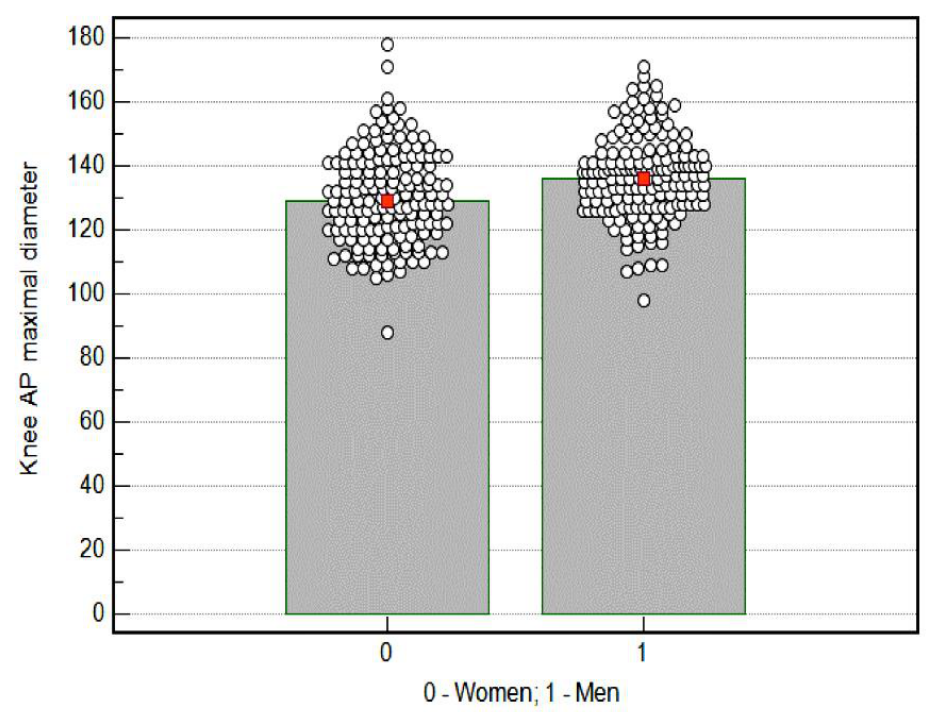
Figure 3. Knee AP (anterior-posterior) maximal diameter results by sex. Red mark—mean; cicular mark—participants.